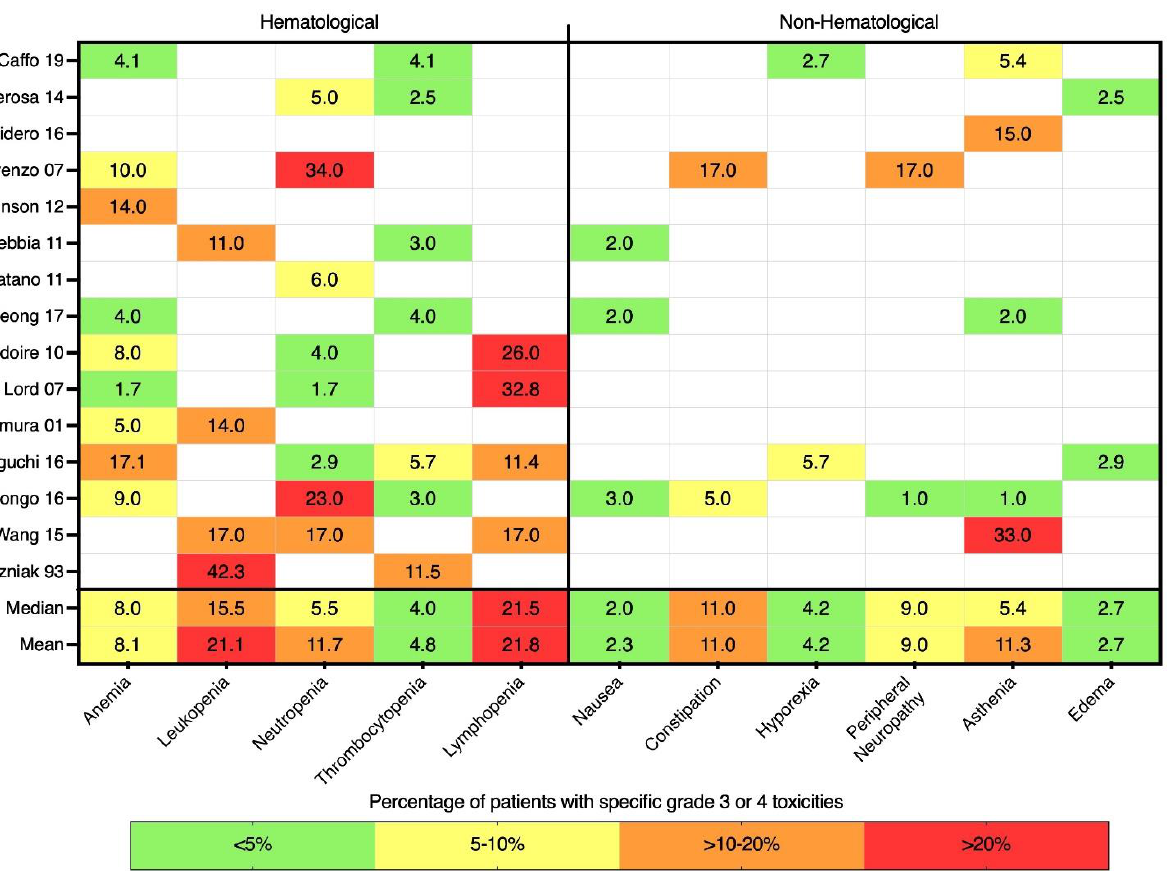
Figure 6. Heatmap of grade 3 and 4 toxicities observed in LDMC studies.